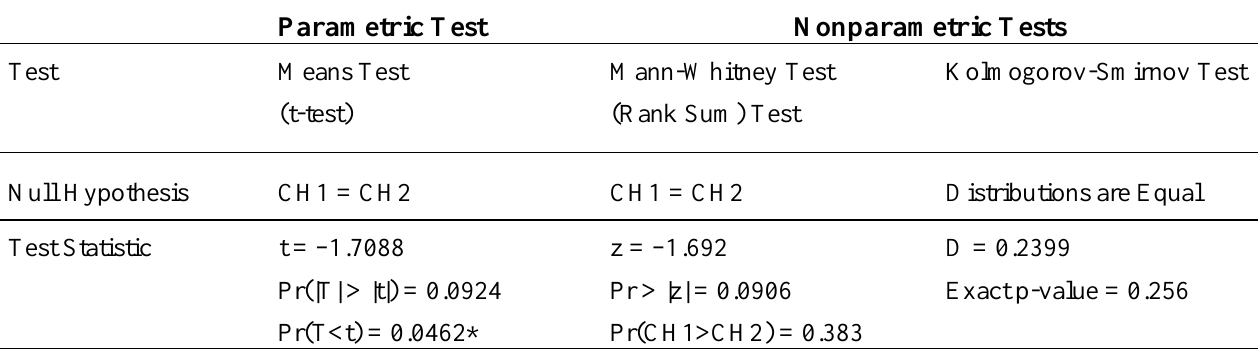
Table 2. Parametric and nonparametric tests of Type X data for CH1 and